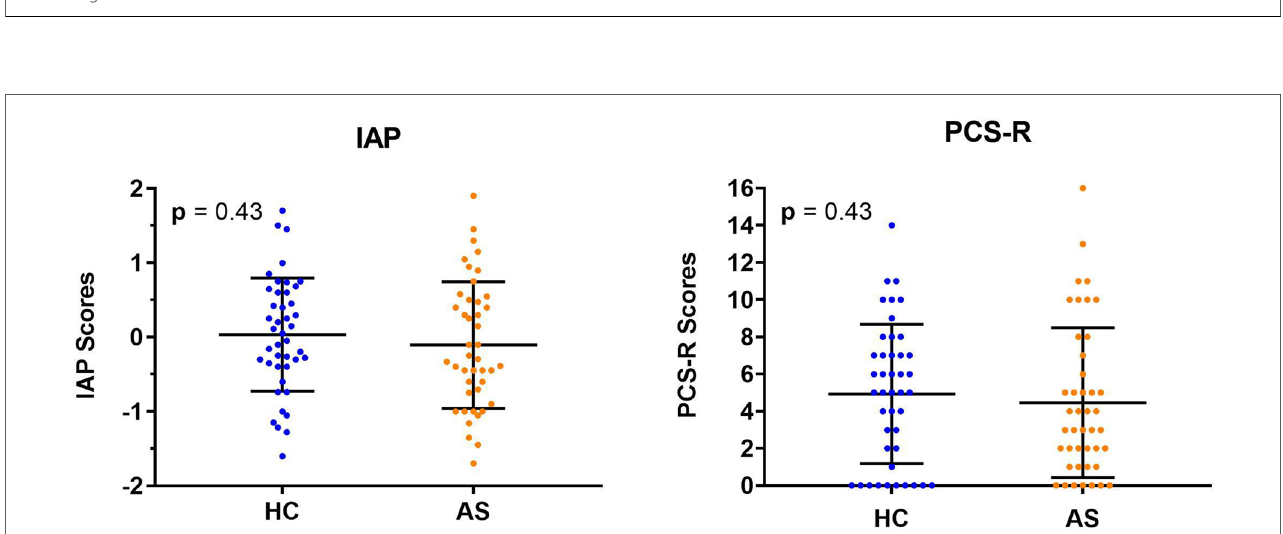
FIGURE 4 Individual and group mean intrinsic attention to pain (IAP) and pain rumination scores. Neither the IAP scores (left panel) or rumination scores (right panel) from the pain catastrophizing scale, rumination subscale (PCS-R) were signi fi cantly different between healthy controls (HCs) and those in the ankylosing spondylitis (AS) group. The HCs are represented by the blue dots. The AS group is represented by the orange